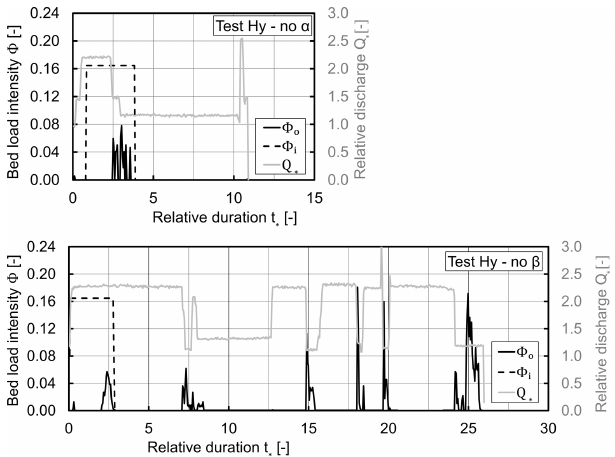
Figure 11. Remaining sediment deposits at the end of the hydro- graph test of case Hy-o.